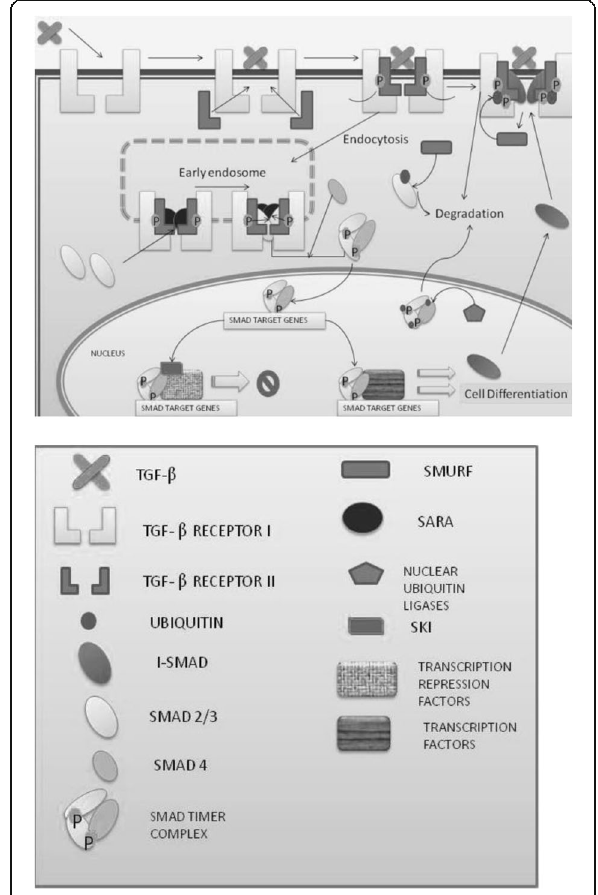
Fig. 1 Signaling pathway TGF β